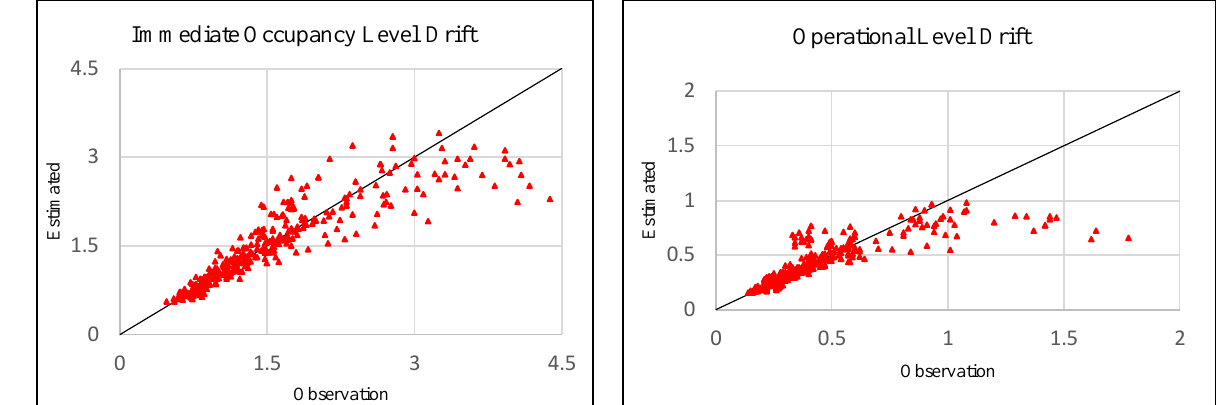
Figure 6. Estimated and statistical samples’ observed